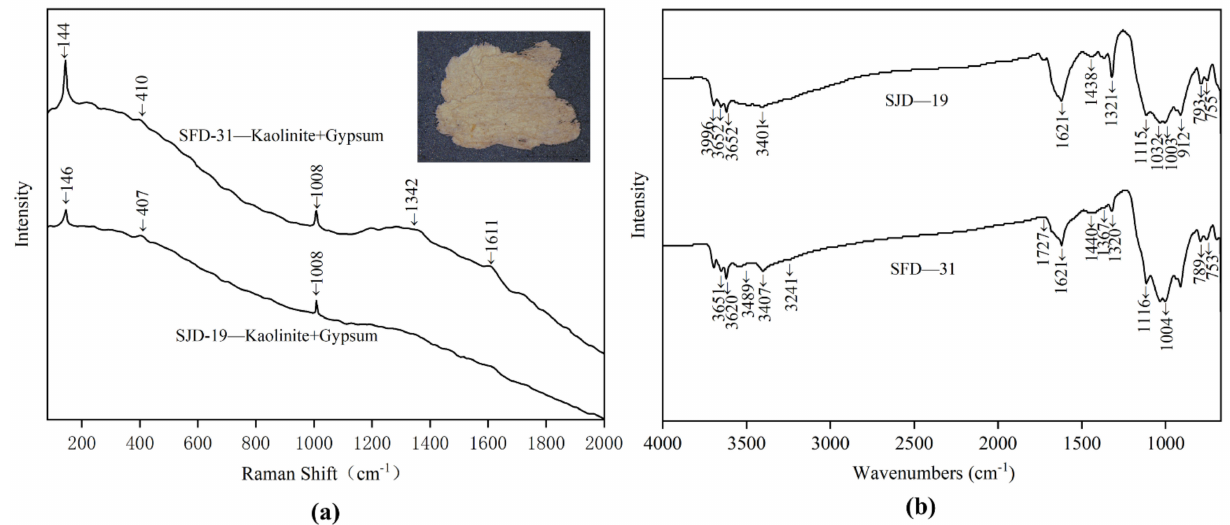
Figure 7. Micro-Raman spectroscopy ( a ) and FT-IR spectra ( b ) of white powder samples SFD-31 and